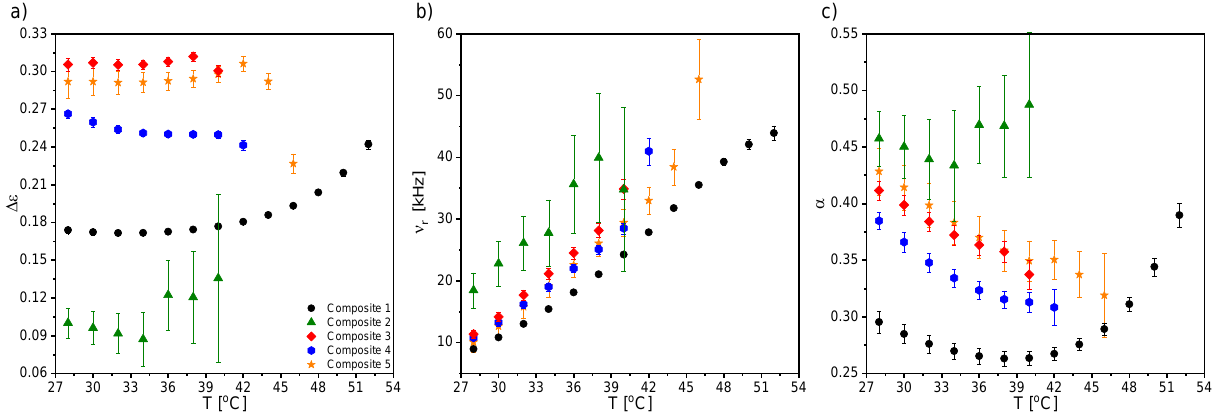
Figure 12. Temperature dependences of the dielectric increment, Δε ( a ); relaxation frequency, ν r ( b ); and distribution parameter of relaxation time, α ( c ) of the relaxation process registered in the crystal phase. Due to the overlapping of two processes for Composite 2, the parameters were subject to large uncertainties. The legend in graph ( a ) is the same for all graphs.